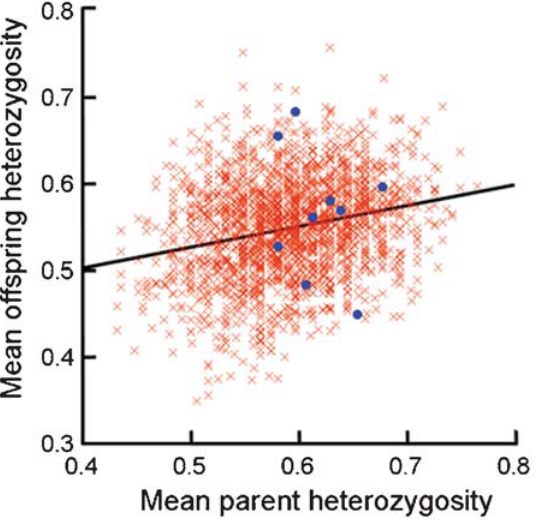
Figure 3. Simulated mean heterozygosity of 100.000 offspring from 2068 pairs of wolves regressed on the mean heterozygosity of the parents. The filled blue circles represent the simulated heterozygosity of offspring from nine actual pairs in the Scandinavian wolf population. The regression slope is 0.241 and r 2 is 0.057.